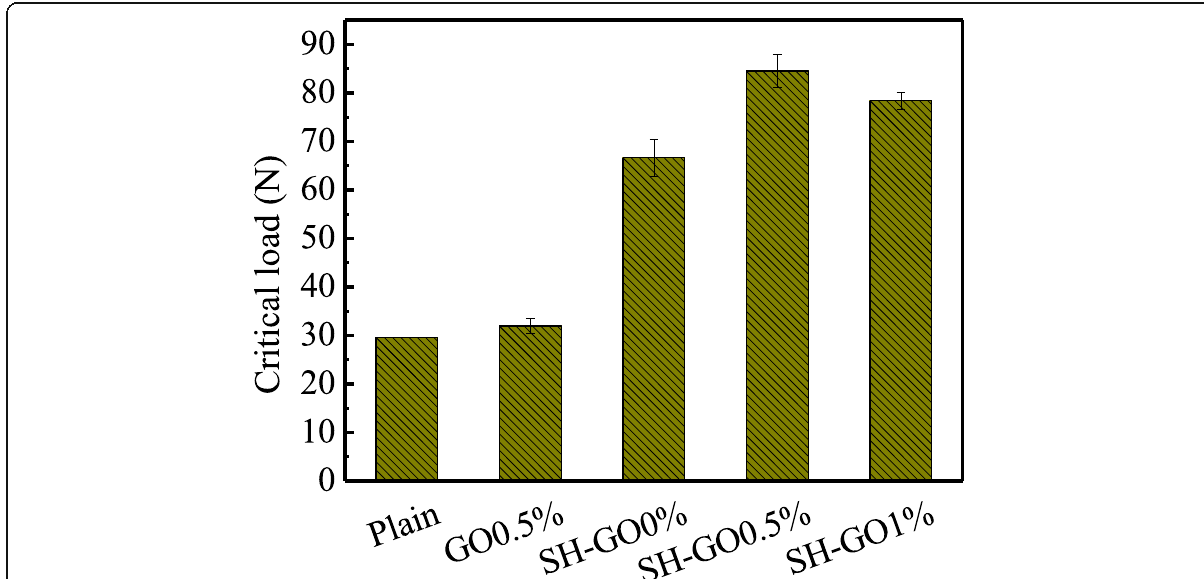
Fig. 9 Critical load P C for various specimens during DCB